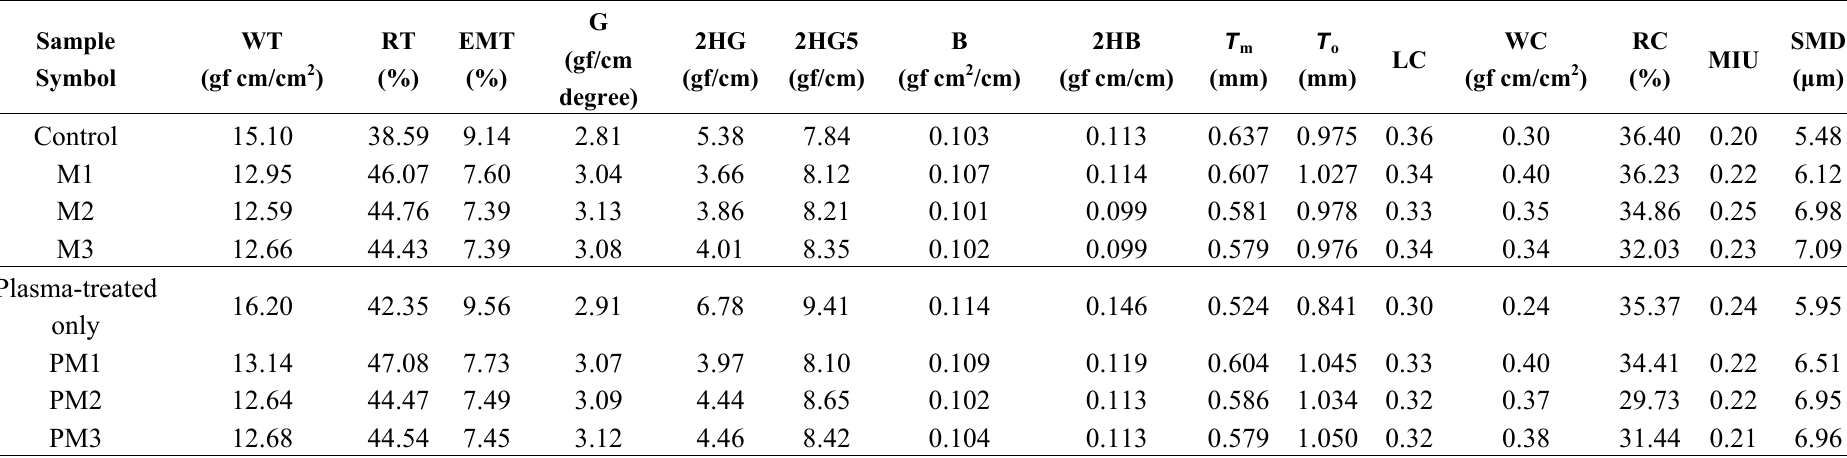
Table 4. Low stress mechanical properties of cotton specimens subjected to anti-microbial treatment. (See Table 2 for definitions of